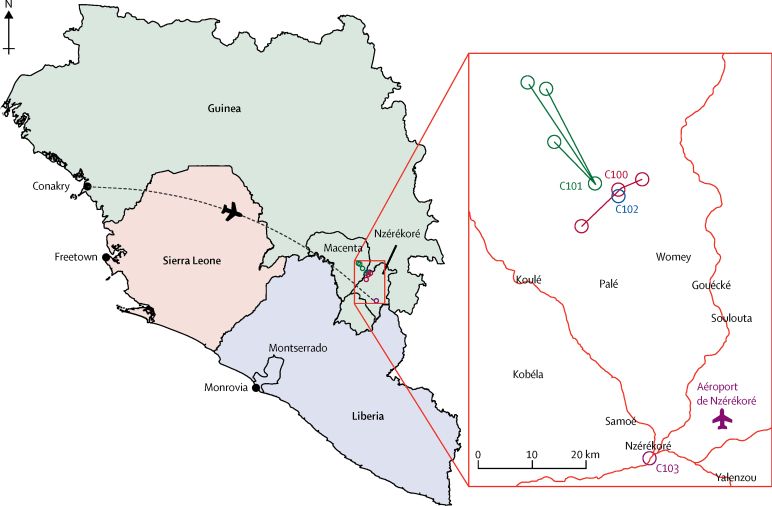
Map of west Africa and location of Nzérékoré prefectureThe flight path indicates how the vaccination teams travelled from Conakry to Nzérékoré. The inset map indicates the location of the four rings defined by their index cases and their contacts and contacts of contacts, including those resident in satellite sites.